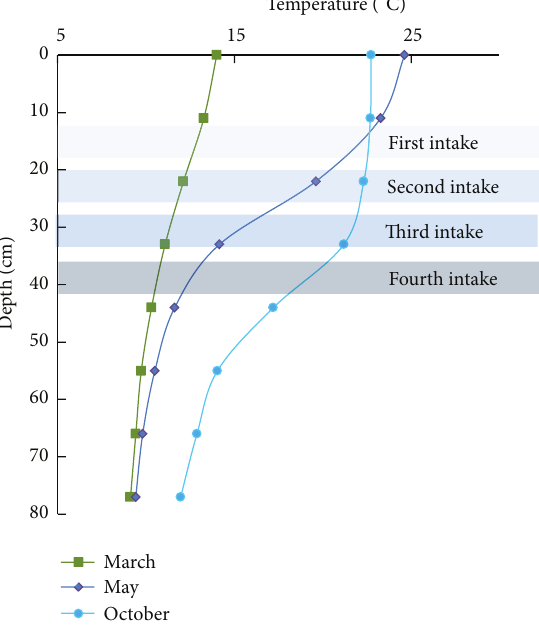
Figure 6: Location of intakes in the experiments. colder when the flow rate increased. The temperature of with- drawn water decreased by 0.24 ∘ C and 0.31 ∘ C, respectively, when the flow rate changed from 1.0 L/s to 2.5 L/s. For the third and the fourth intakes, the withdrawn water became hotter when the flow rate increased. The temperature of the third intake increased from 15.58 ∘ C to 16.17 ∘ C when the